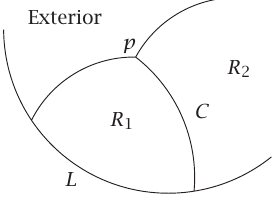
Figure 6.5 . C intersects the axis of rotation L without returning to the boundary of the exterior.